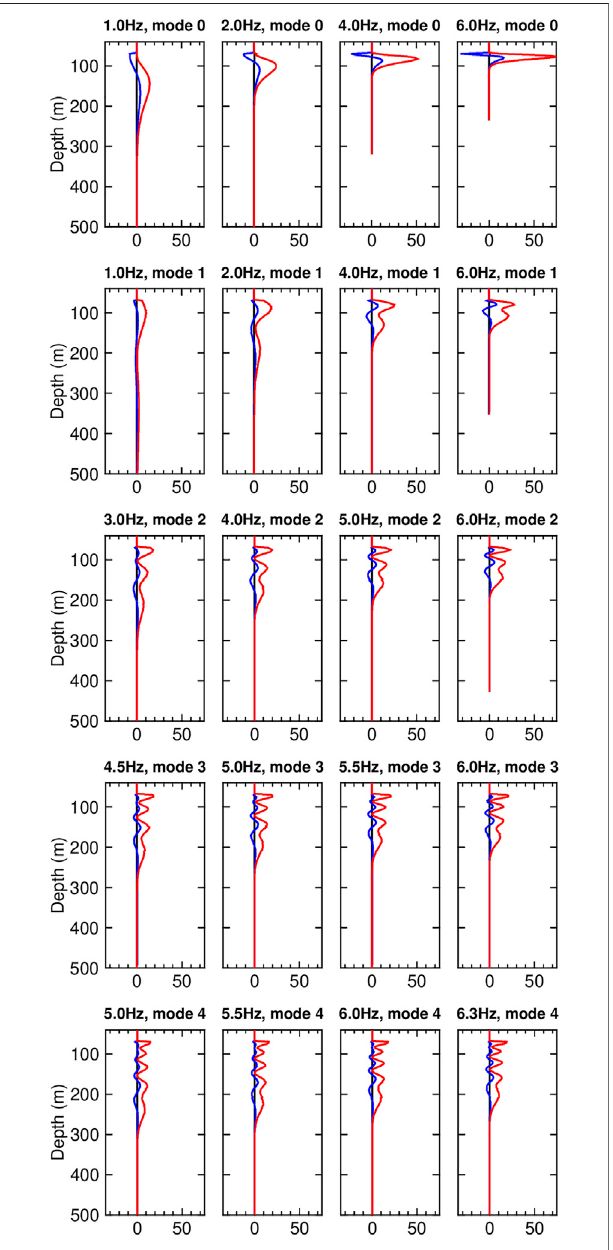
FIGURE8| Sensitivitykernelsofthe fi vedispersiveScholte-wavemodes based on the initial marine sedimentary model. The red, blue, and black lines denote the sensitivities of v s , ρ , and v p , respectively. Modes 0 – 4 denote the Scholte-wave dispersive fundamental to the fourth higher-order modes, respectively.